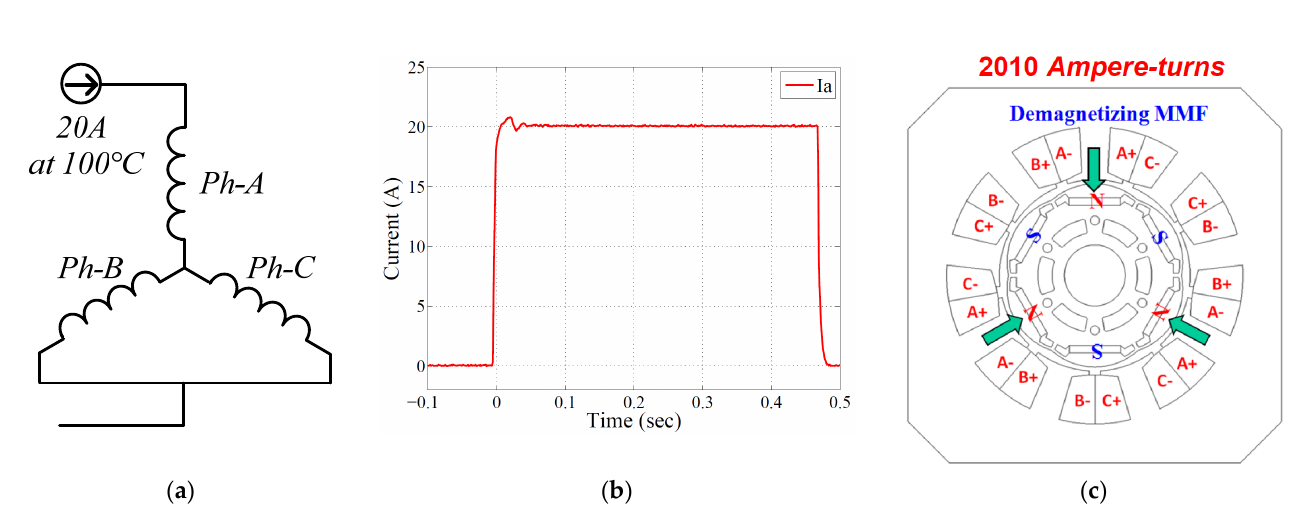
Figure 10. ( a ) Winding schematic; ( b ) current pulse waveform; ( c ) rotor position during locked-rotor test.